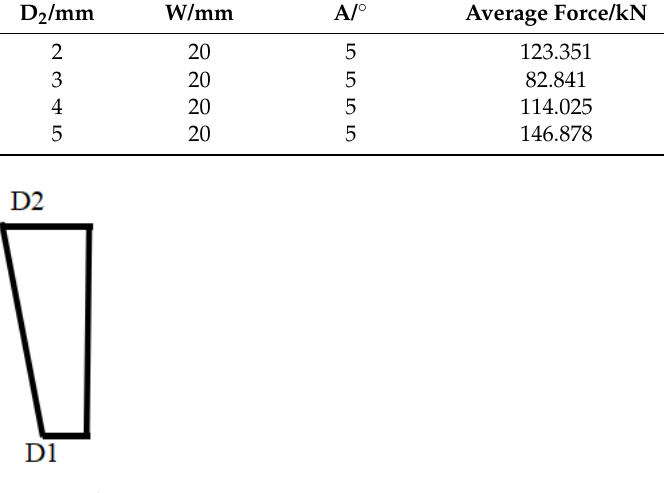
Figure 8. The cutting zone.